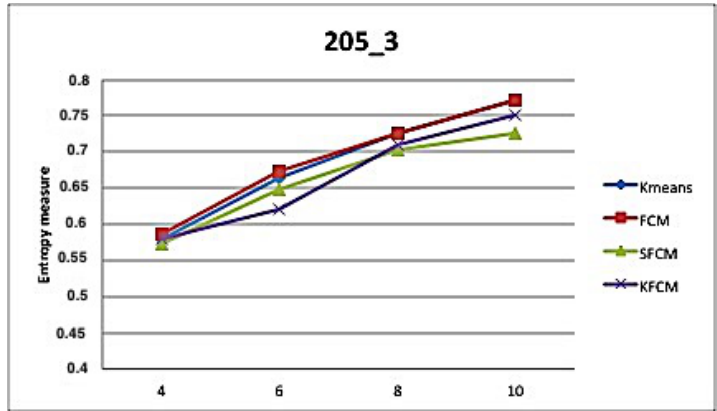
Figure 5. Entropy-based evaluation measure for the clustering algorithms on Image 202-3 and on Image 205-3 using the optimal parameter setting.